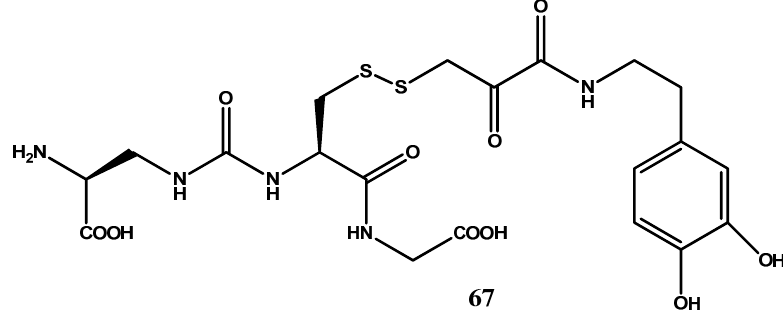
Figure 11. Glutathione conjugated prodrug of dopamine, 67 .